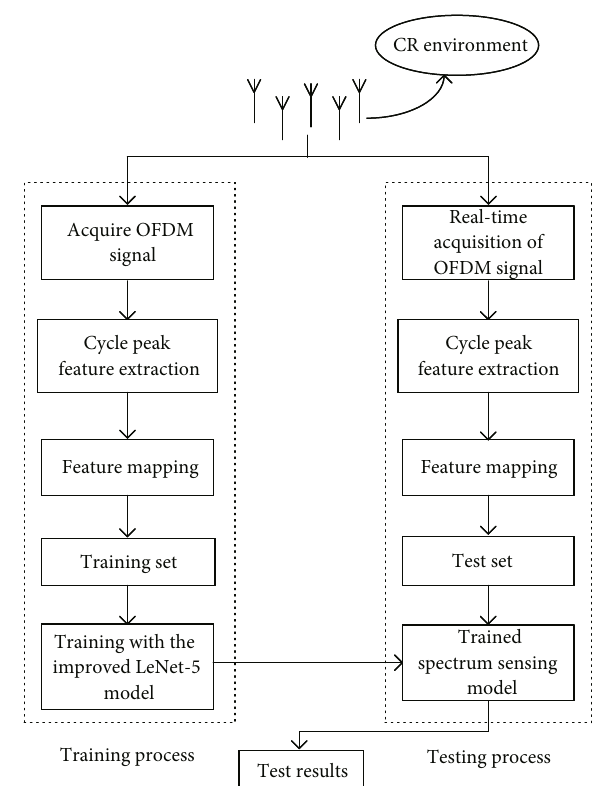
Figure 6: The framework of spectrum